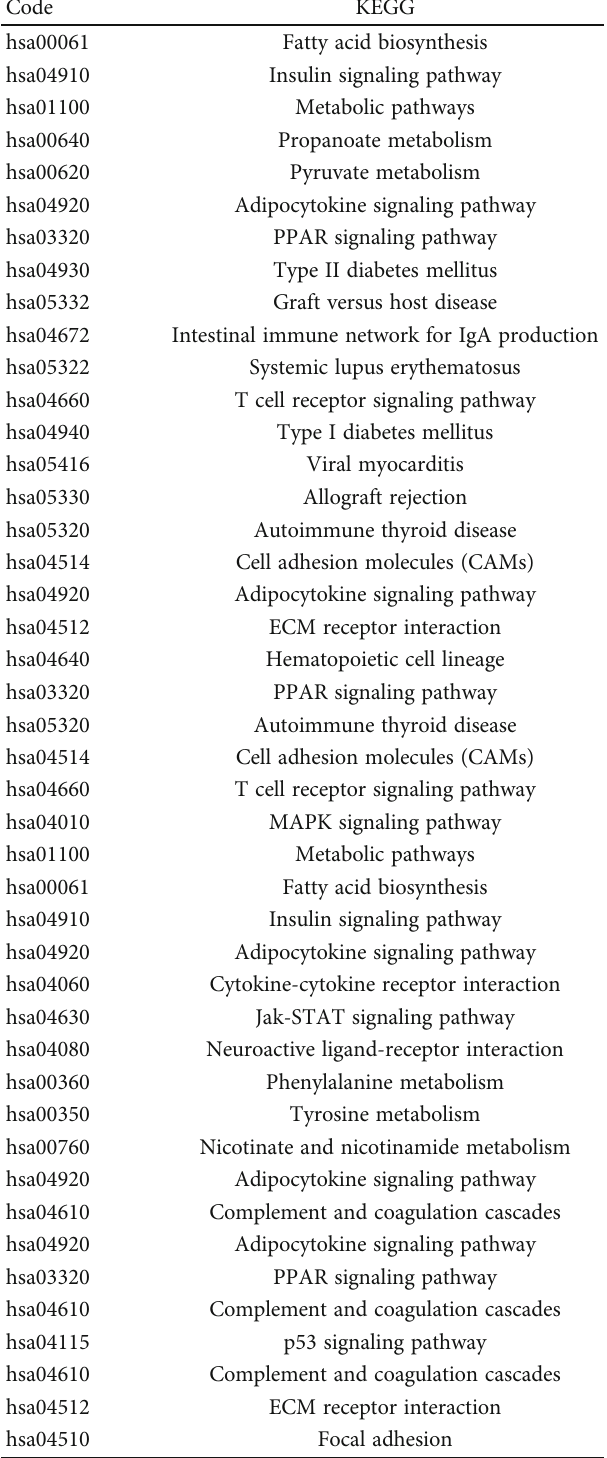
Table 3: Information on KEGG pathways linked with diabetes type 2. Code